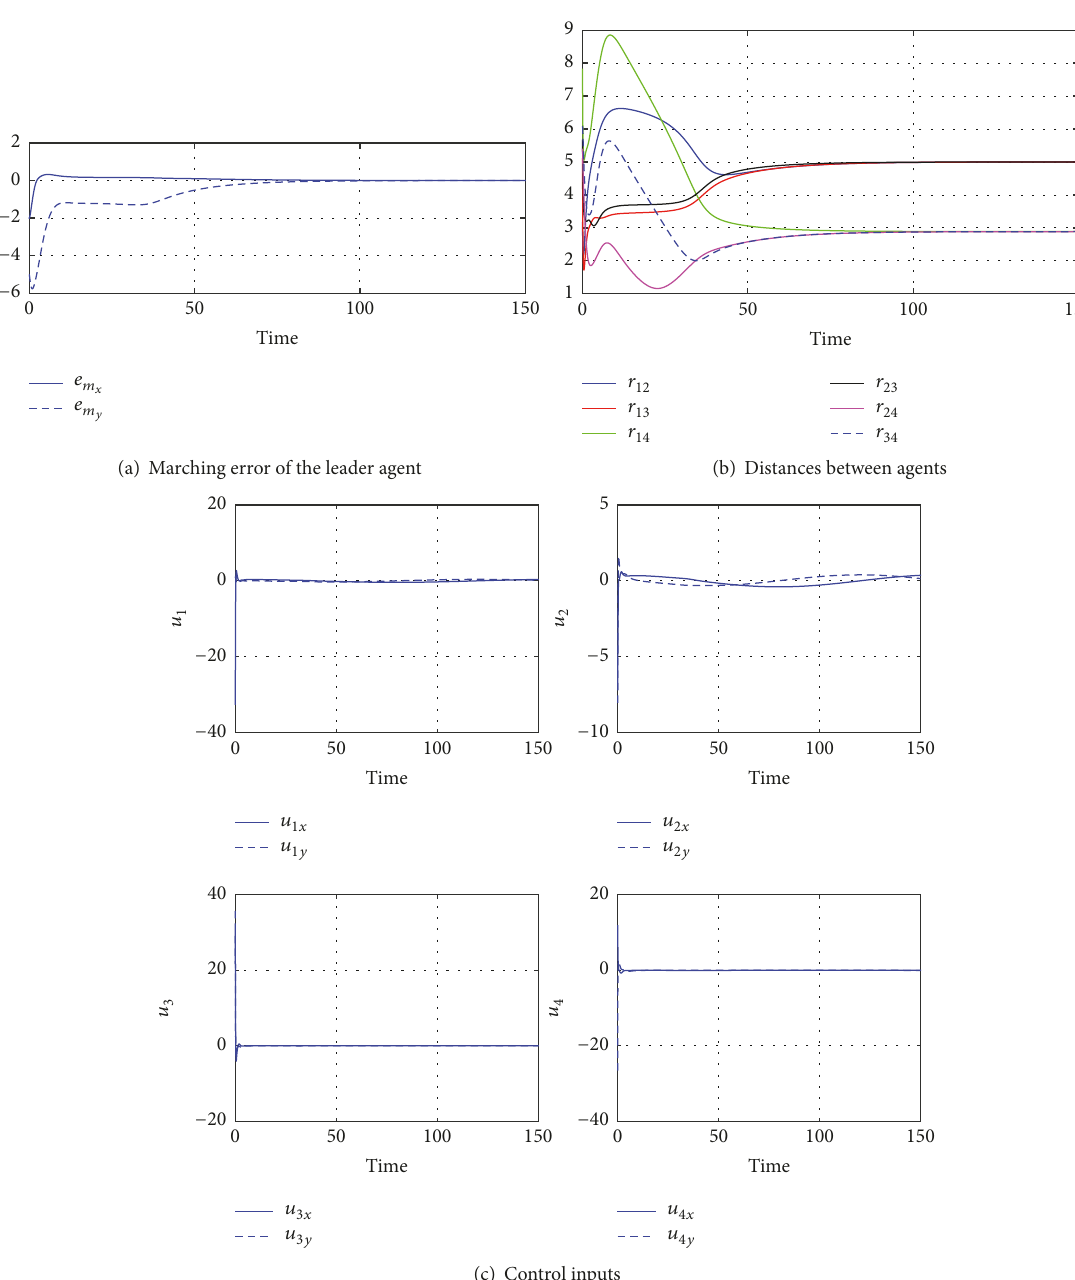
Figure 8: Simulation 2 results of distance and area formation control with 𝑛 = 4 , 𝑛 1 = 2